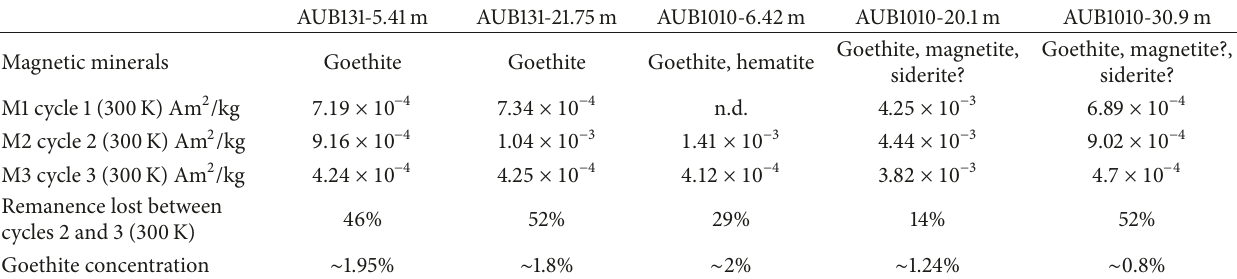
Table 2: Main results of magnetic remanence measurements: major magnetic Fe-bearing minerals, values of magnetic remanence measured at 300 K during the three successive cycles, loss of remanence between cycles 2 and 3, and estimation of goethite in samples.